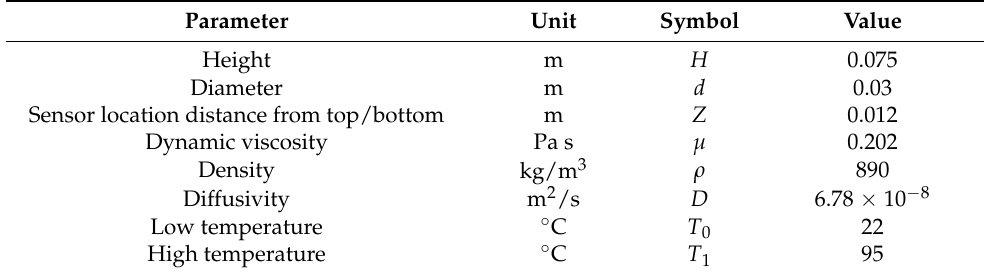
Table 2. Parameters, units, and reference values.